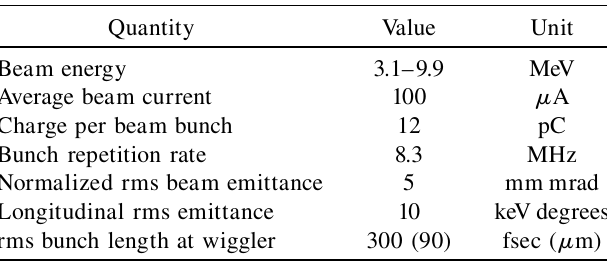
TABLE I. THz source accelerator